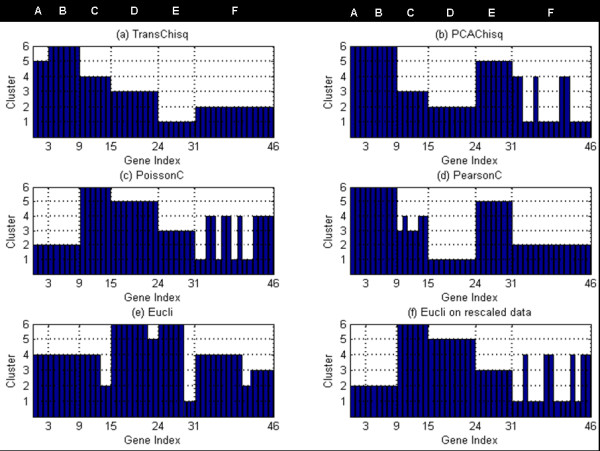
Graphs of clustering results for the simulation data. Horizontal axis represents the index of the 46 genes which belong to six groups (designated A, B, C, D, E and F, and marked at the top of the figure); vertical axis represents the index of the cluster that each gene has been assigned to by each algorithm.